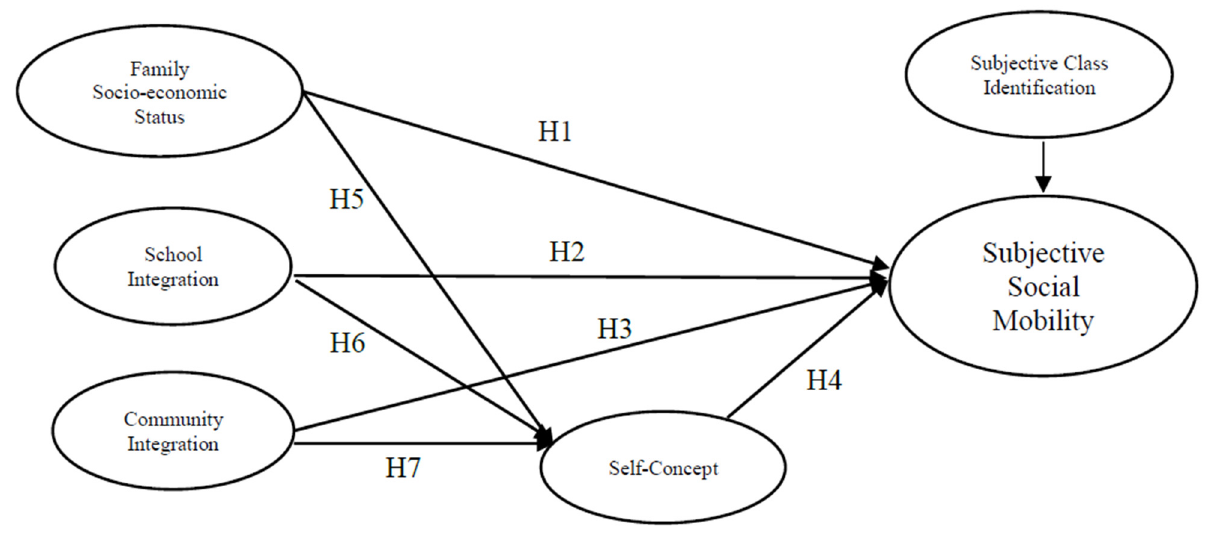
Figure 1. Theoretical framework of migrant children’s subjective social mobility.